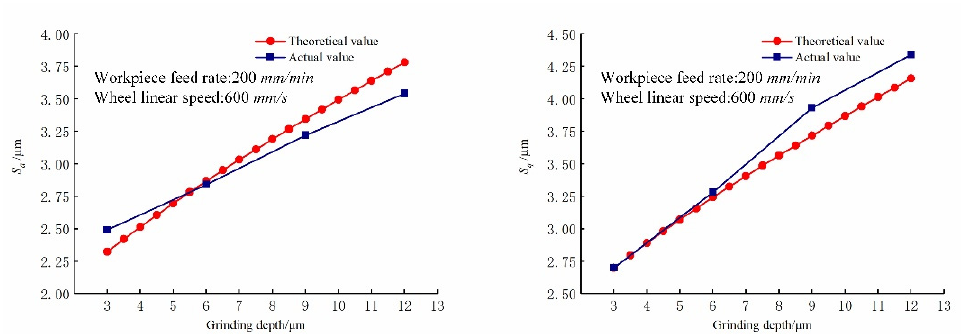
Figure 8. Effect of grinding depth on the three-dimensional surface roughness. (Feed rates: 200 mm/min, Grinding wheel linear speeds: 600 mm/min).